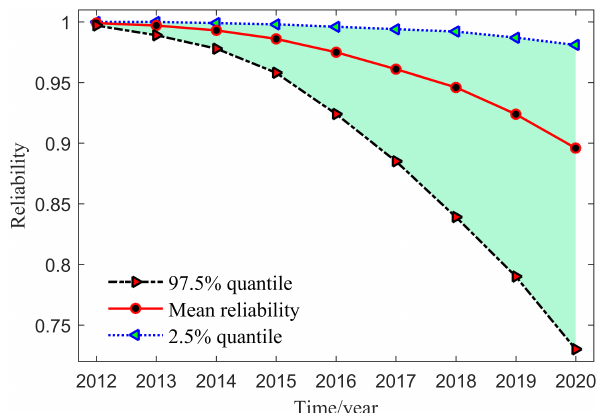
Figure 8. The prediction curve for the reliability of electrical meters. The quantile represents the boundary value of the